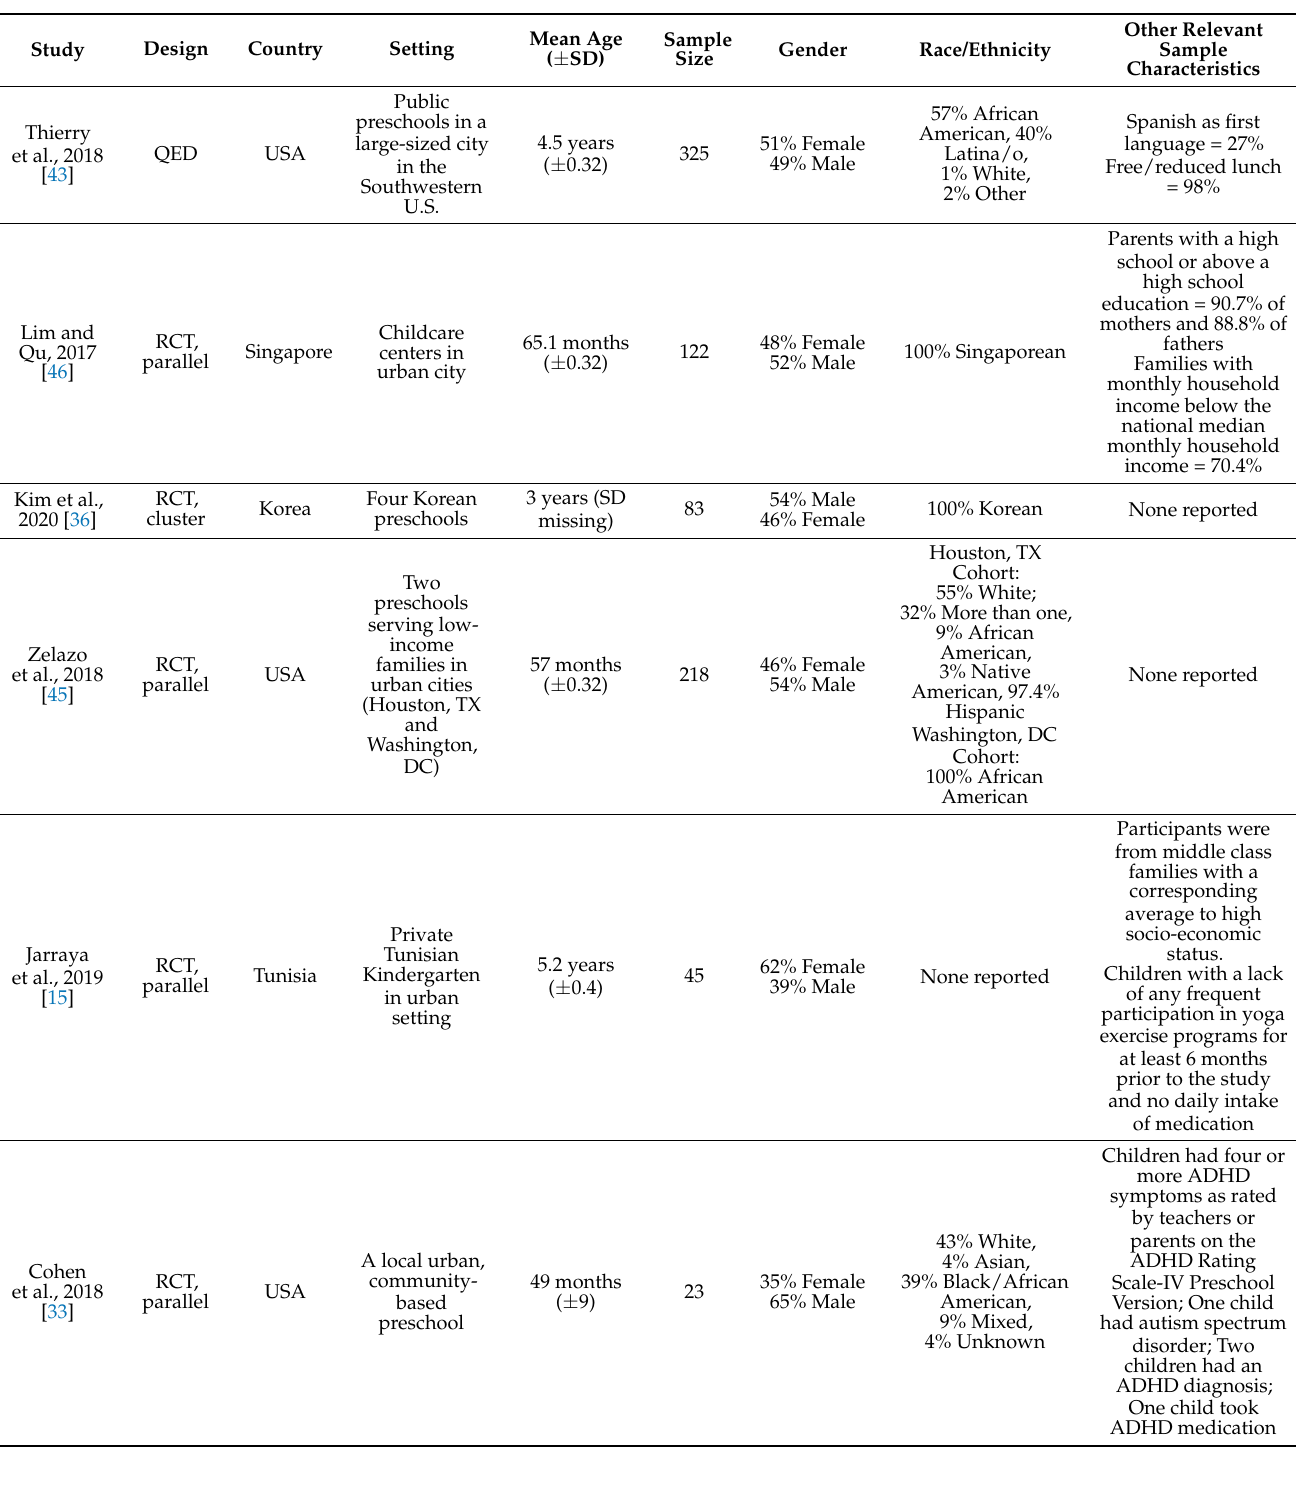
Table 1. Descriptive information about study location, setting, and participant